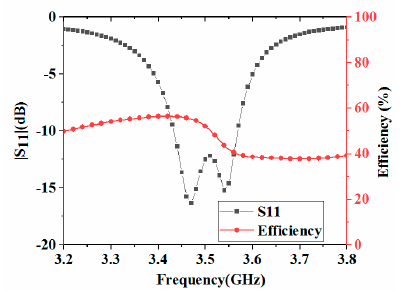
Figure 3. Simulated |S 11 | and radiation efficiency of the antenna element.